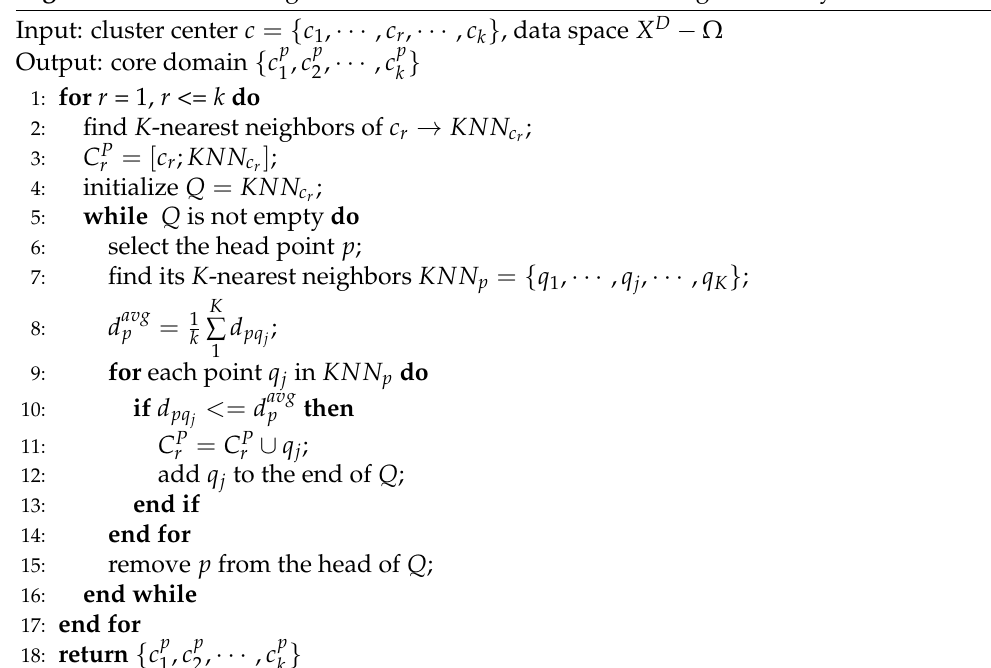
Algorithm 1 Determining the core domain based on the average